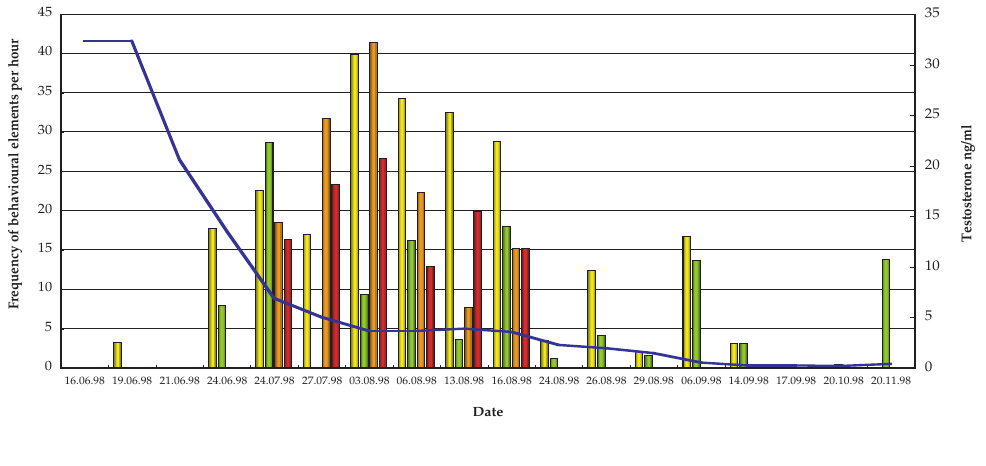
Fig. 6. Frequency of interactions (yellow), non sexual contacts (green), erections (orange) and mating attempts (red) during dedicated observations (morning and evening observations combined) between July 1998 and December 1998. The frequency is expressed as the number of events per hour. Note that the date axis is not drawn to scale. Observations were conducted at all the dates mentioned, i.e., no bar indicates that the specific behaviour was not observed. The testosterone profile during the same period is indicated (blue